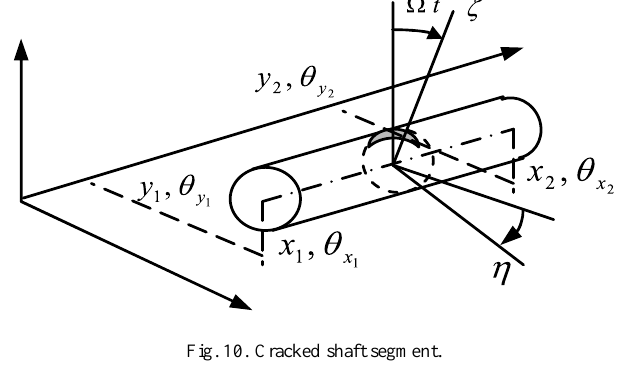
Fig. 10. Cracked shaft segment.